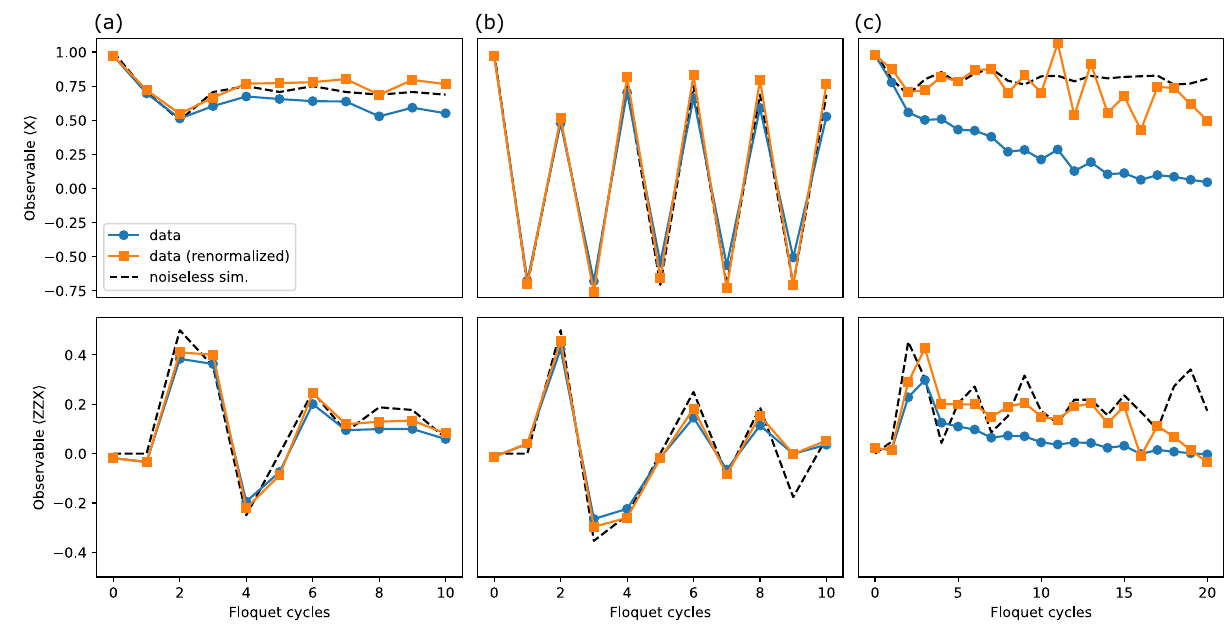
Fig. 5 | Experimental data. The fi gure shows the raw data for the expectations of the operators X 0 (top) and Z 0 Z 1 X 2 (bottom) for noiseless simulation (dashed black curve), the experimental data (circles, blue), and rescaled experimental data (squares, orange),where the rescaling takes the form exp ð Γ n Þ , where n isthe index of the Floquet cycle and Γ is the compensated decay rate. This rescaling accounts